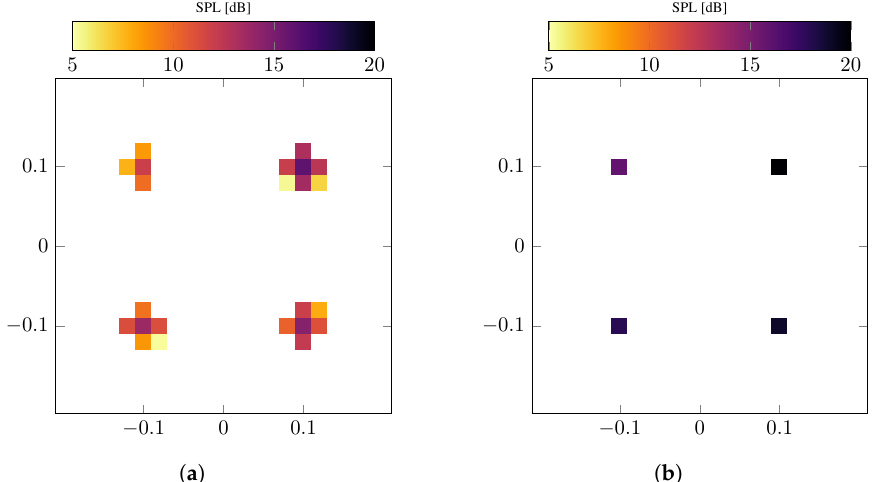
Figure 4. Solutions for numerical example with random phase perturbation. ( a ) FISTA solution with perturbed phase